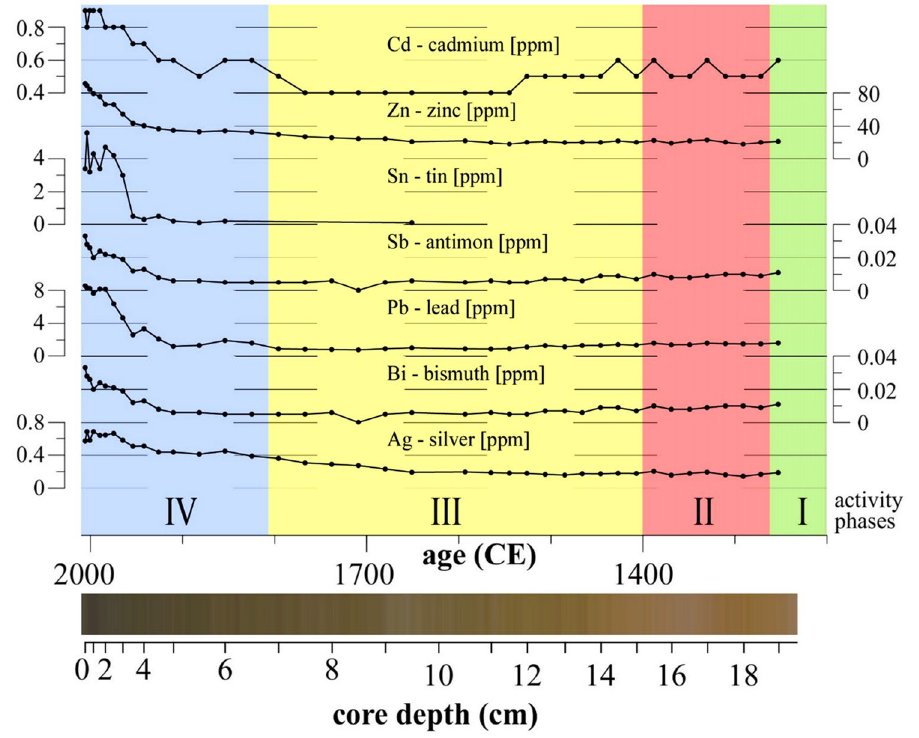
Figure 5. Metal concentrations of industrial air-borne pollution in sediment core NP-2; concentrations in ppm; interpreted activity phases I–IV at Native Point; sediment colors of age-corrected core